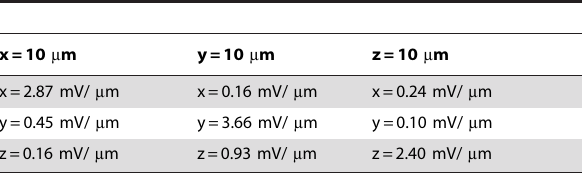
Table 2. Cross axis correlations (displacement amplitude is given on top of each column).